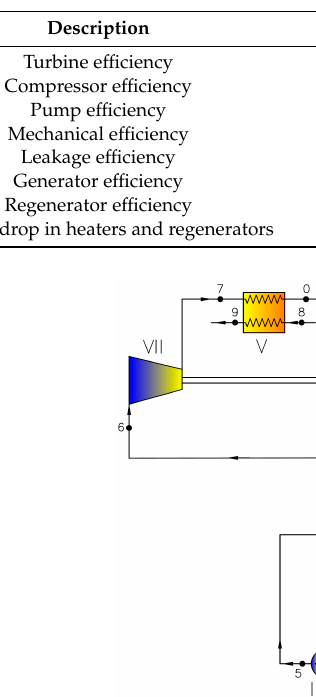
Table 1. Assumed values of the efficiencies of particular cycle elements.